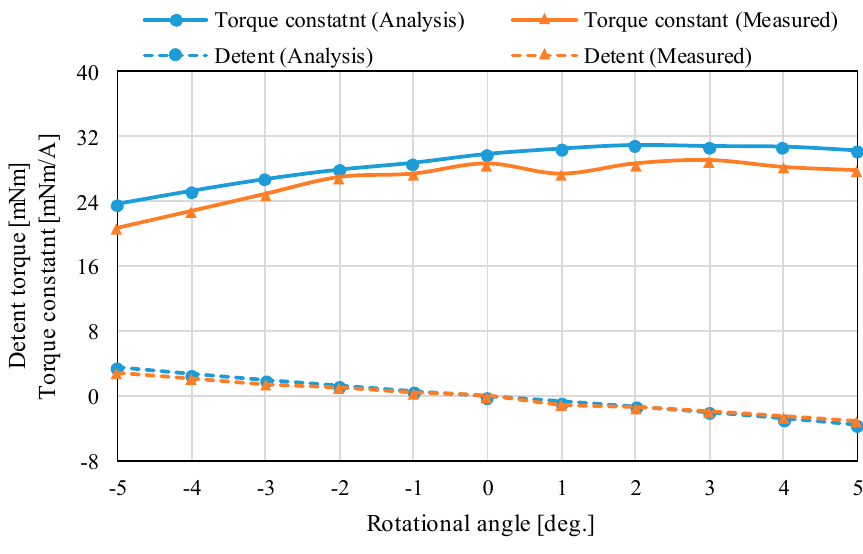
Figure 14. Torque characteristics in the X -axis.